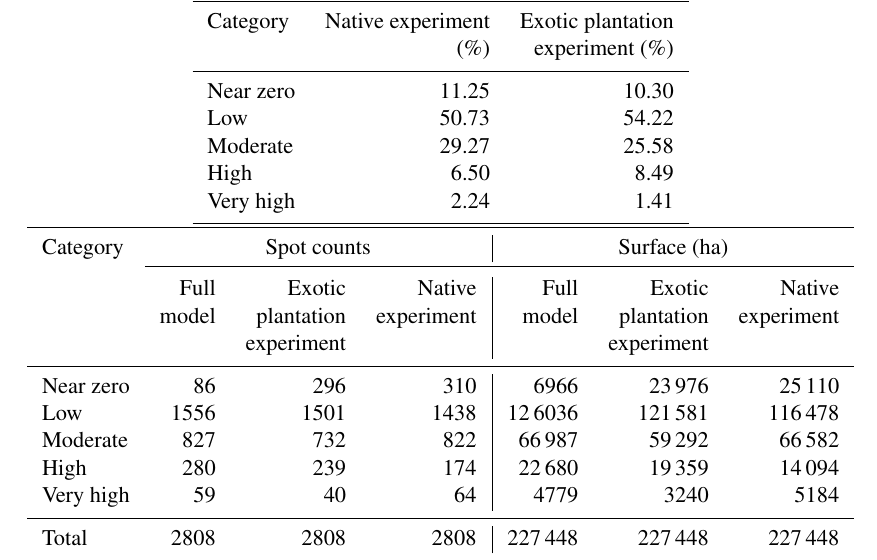
Table 4. Modeled proportion of spot recurrence within the CMA (%) according to the five categories, considering the scenarios in which the whole study area is assumed to be covered by native vegetation (native experiment) and exotic plantations (exotic plantation experiment). The lower section of the table compares spot counts and the surface area per category relative to the full model using the original database and to the